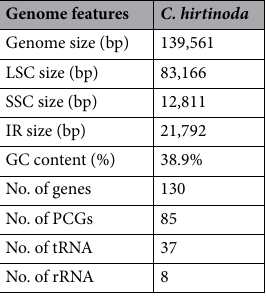
Table 1. Summary of the chloroplast genome of C. hirtinoda .